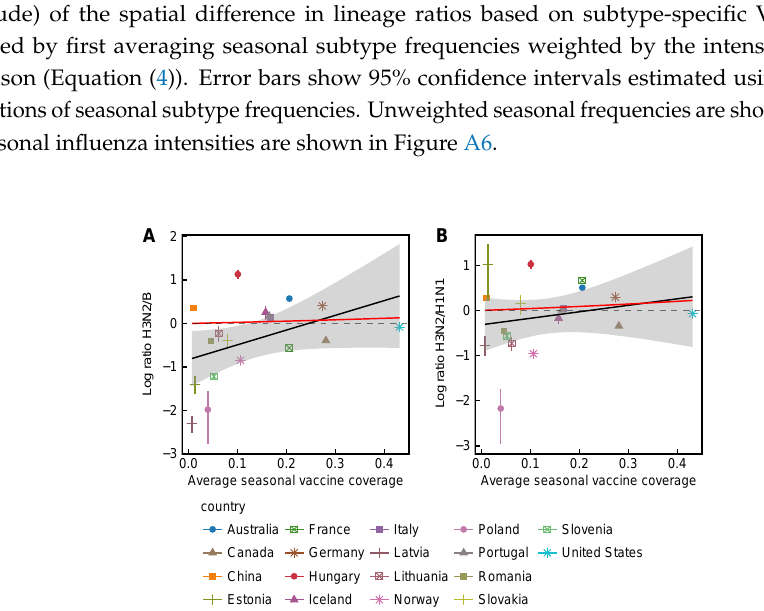
Figure 3. Differences in countries’ subtype ratios are partially consistent with vaccine-driven selection. ( A ) the ratio of H3N2 to B among countries does not significantly correlate with the average seasonal vaccine coverage (Pearson’s r = 0.24, p = 0.33); ( B ) the ratio of H3N2 to H1N1 among countries significantly correlates with the average seasonal vaccine coverage (Pearson’s r = 0.50, p = 0.03). Subtype ratios are adjusted for seasonal influenza intensity (Equation (4)). Error bars show 95% confidence intervals estimated using multinomial distributions of seasonal subtype frequencies. Red lines show expectations based on Equation (A23), estimated using VE measured in Canada, and are identical to the trajectories shown in Figure 1. Dashed lines representing no effect of vaccination on subtype ratios are placed for visual reference. The number of seasons contributing to each data point is shown in Figure